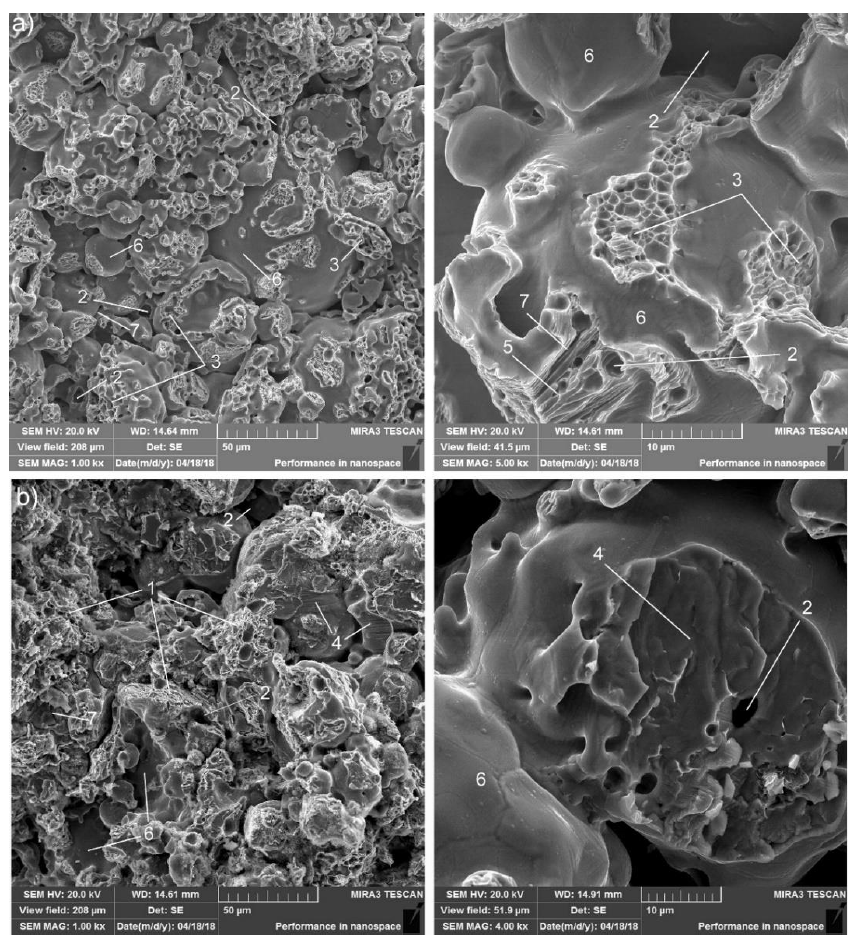
Figure 8. Fractographies of FeGr1 ( a ) and FeGr2 ( b ) material: 1—areas of quasi-brittle fracture; 2—pores; 3—areas of viscous fracture; 4—areas of brittle cleavage; 5—perlite grain destruction; 6—areas of inter-granular fracture; 7—microcrack.